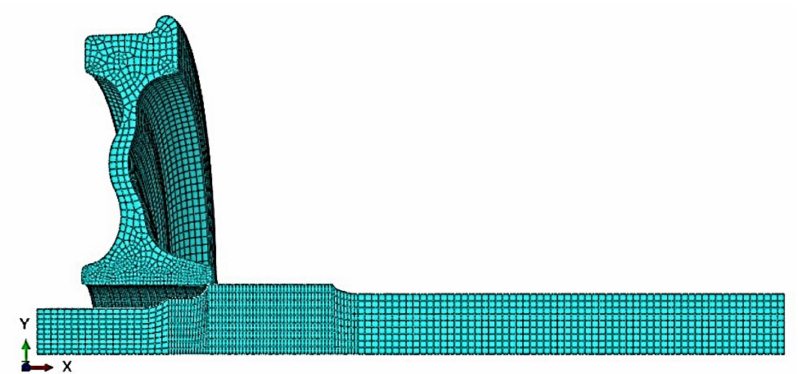
Figure 7. Mesh used by the finite element